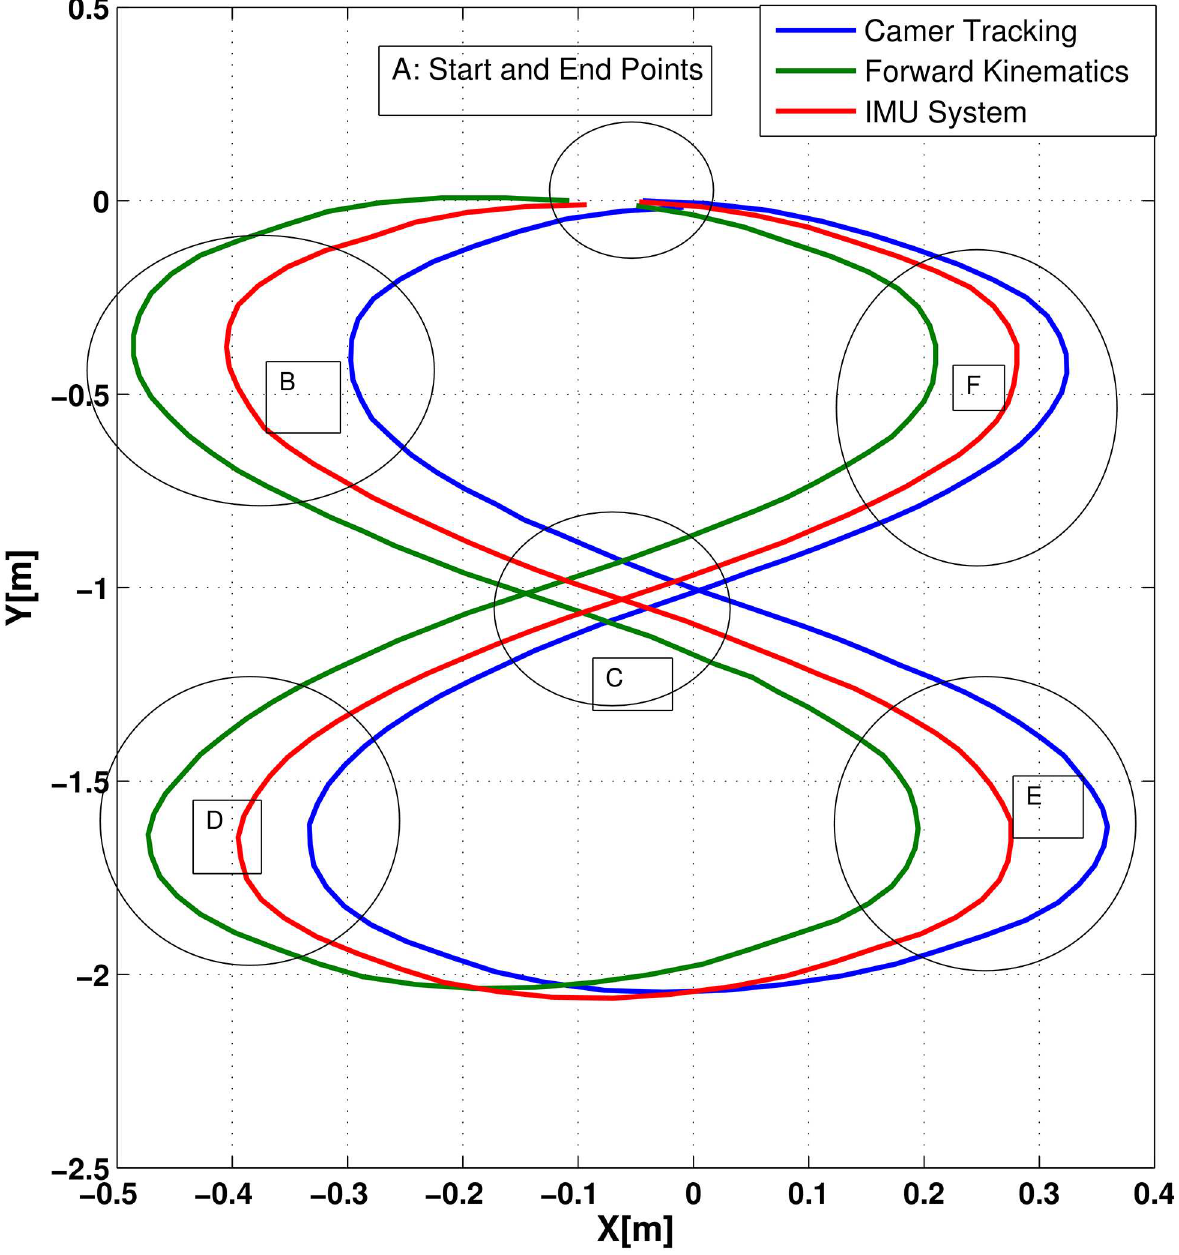
Fig 17. Infinity shape trajectoriesfor FK, IMU and camerapositioning